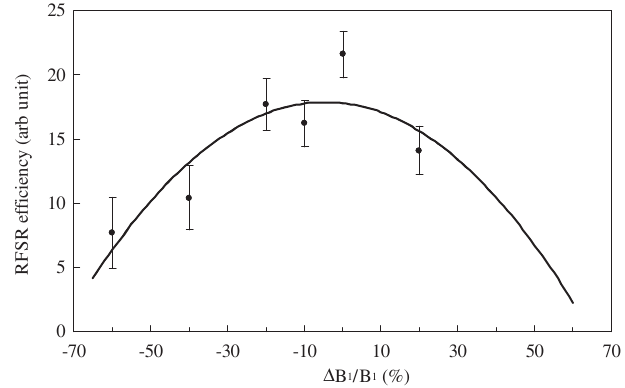
FIG. 11. The spin-flip efficiency of the RFSR is shown as a function of a relative change in the rf field (cid:2) B flip efficiency measurement with cold neutrons is based on the well-known parity-violating (cid:1) -ray asymmetry on 35 Cl at cold neutron energies (see text). The solid line is a fit to a quadratic function.